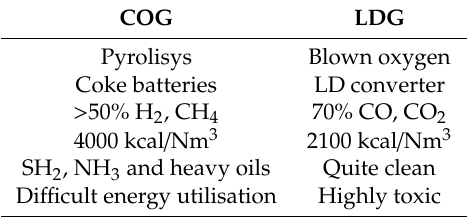
Table 1. Main characteristics of coke oven gas and Linz–Donawitz converter gas.